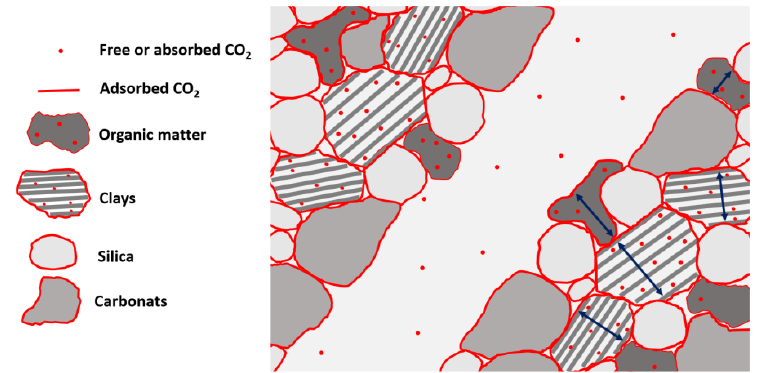
Figure 4. Schematic illustration of CO 2 adsorption on mineral grains, absorption inside the organic matter, and clay particles in true dry conditions. The swelling of clays and organic matter resulting from the absorption of CO 2 is depicted by arrows.